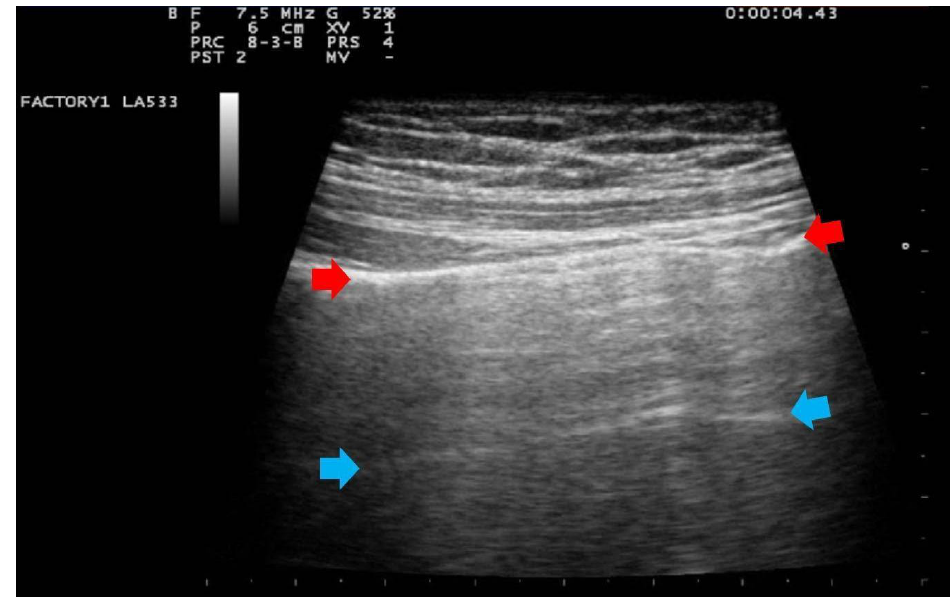
Figure 1. Lung US images obtained with linear transducers., frequency 7.5 MHz, focus on the pleural line. Trapezoidal view. The pleura line (indicated by red arrows) is continuous. Below, horizontal artifacts (A line), indicated by blue arrows, may be visible. This pattern is classified as score